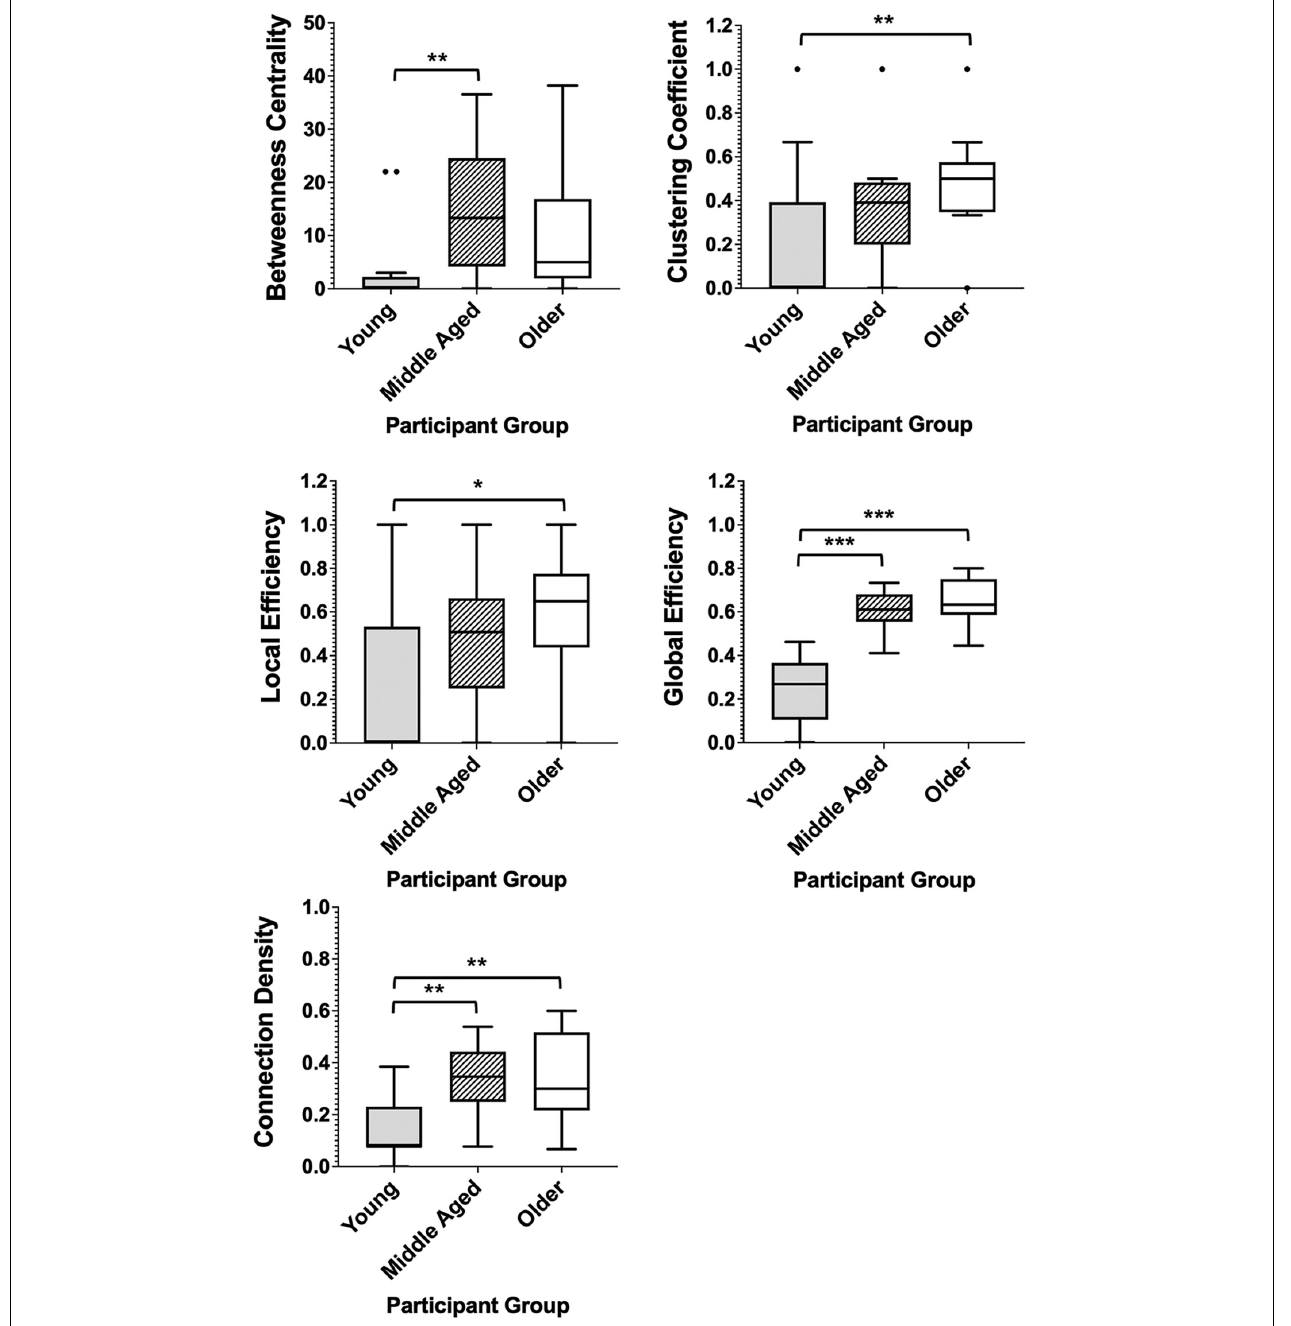
FIGURE 4 | Box plots showing the median and interquartile range of network metrics for the graphs of the healthy groups. Significant differences calculated using independent two-tailed Mann–Whitney U tests. * p < 0.05, ** p < 0.01, *** p < 0.001 (Bonferroni correction for multiple